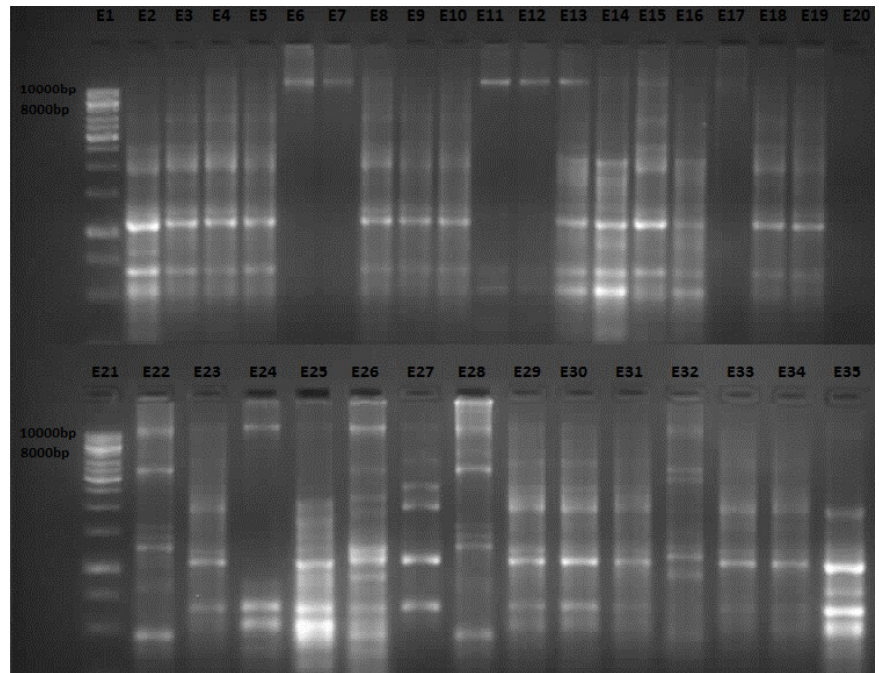
Figure 1. Enterobacterial repetitive intergenic consensus (ERIC) polymerase chain reaction (PCR) profiles of representative Escherichia coli ( E. coli ) O157:H7 isolates from the different sources. Lanes E1 and E21, 1 kb DNA ladder; Lanes E2–E6, isolates from water samples; Lanes E7–E13, isolates from cattle feces; Lanes E14–E20, isolates from beef; Lanes E22–E28, isolates from pig feces; Lanes E29–E34, isolates from pork samples; Lane E35, isolate from human stool